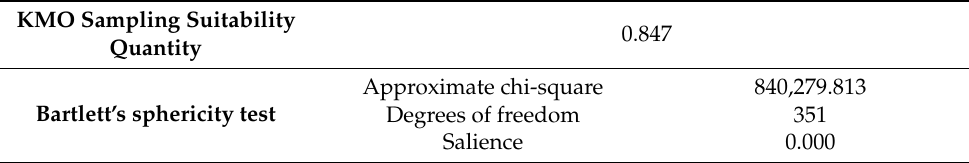
Table 6. KMO and Bartlett test of the simulated driving test